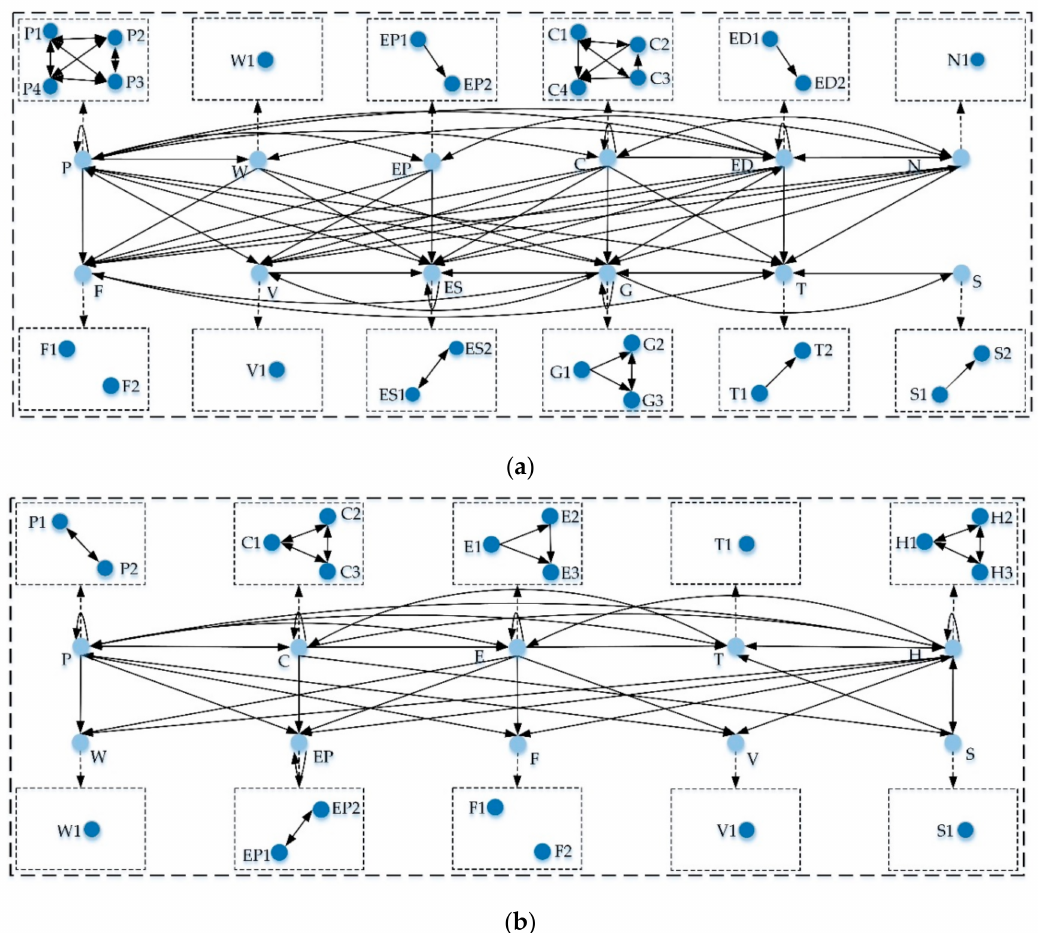
Figure 2. Network relation map; ( a ) Preparedness; ( b )